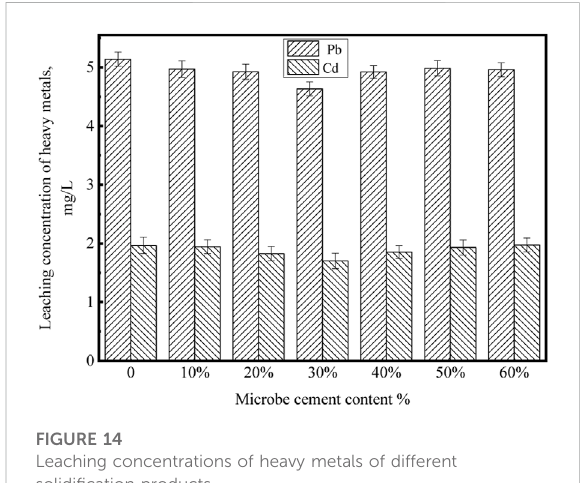
FIGURE 14 Leaching concentrations of heavy metals of different solidi fi cation